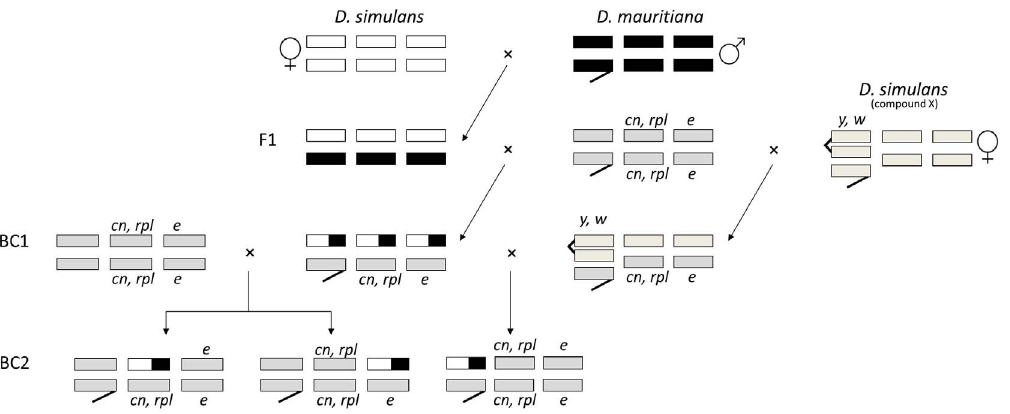
Figure 1. Creation of chromosome introgression (IG) strains. Black bars are used for D. mauritiana chromosomes and non-black for D. simulans .